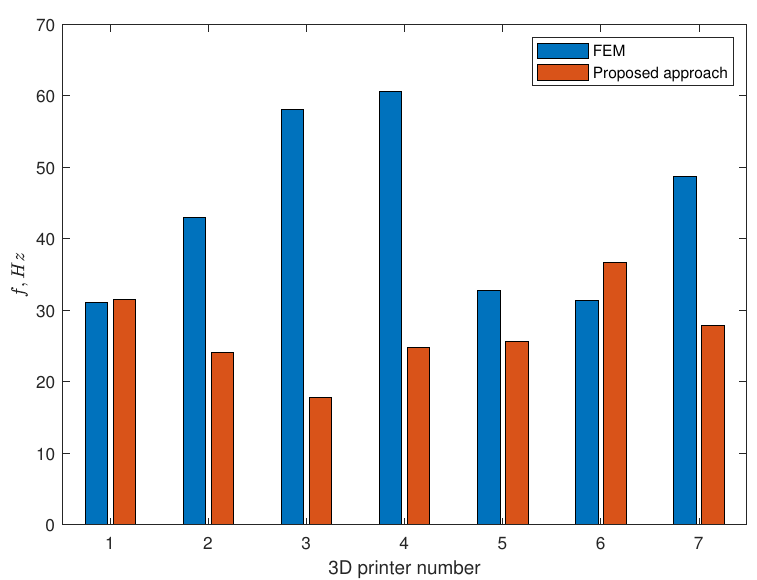
Figure 12. Lowest normal modes of 3D printer structures found by the FEM and by the proposed approach based on a flexible joint model.